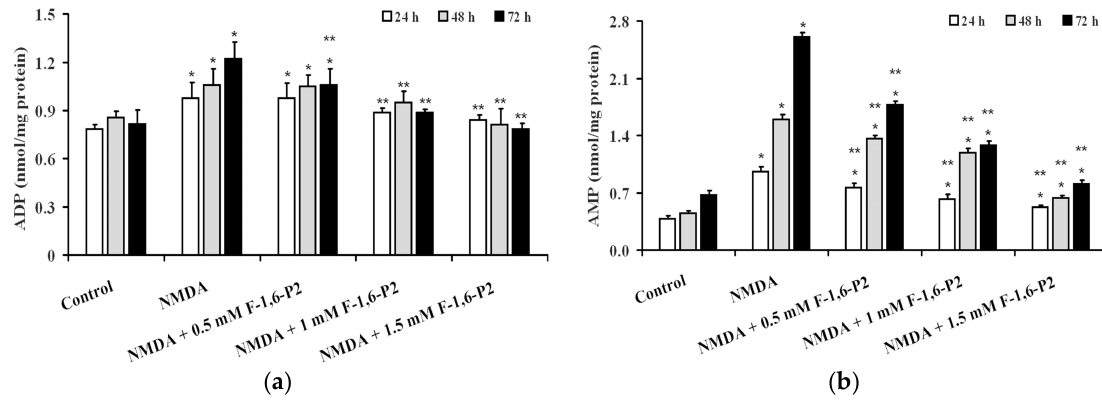
Figure 3. Effects of F-1,6-P2 on the imbalance of adenine nucleotide metabolism in NMDA-treated OHSC. OHSC were challenged with 30 μ M NMDA for 3 h and then incubated without and with increasing concentrations of F-1,6-P2 (0.5, 1 and 1.5 mM) for different times (24, 48 and 72 h). Control OHSC were incubated for the same time intervals, with no prior NMDA treatment or F-1,6-P2 addition. ADP ( a ) and AMP ( b ) were determined by HPLC in deproteinized cell extracts. Histograms are the mean of 6 different OHSC preparations. Standard deviations are represented by vertical bars. * Significantly different from corresponding time of control OHSC, p < 0.001. ** Significantly different from corresponding time of NMDA-challenged OHSC with no F-1,6-P2 supplementation, p < 0.001.